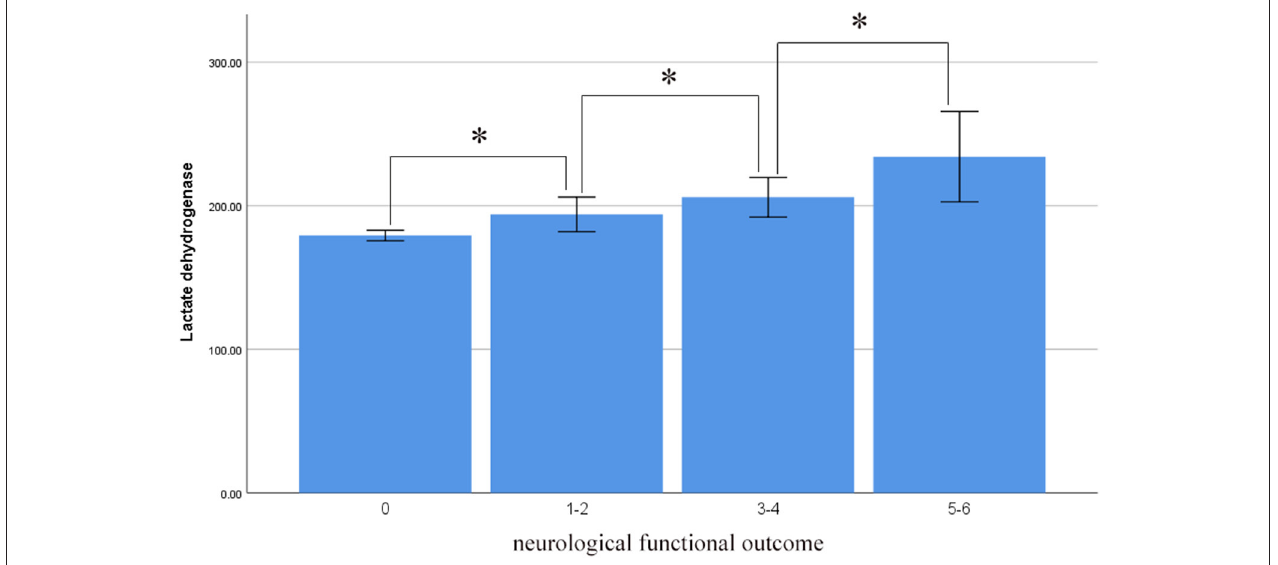
FIGURE 5 | Average level of serum LDH in different neurological functional outcome (asterisk represent statistically significant differences).